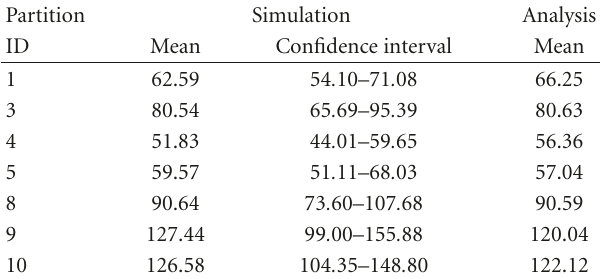
Table 3: Statistics of the node inter-arrival time.